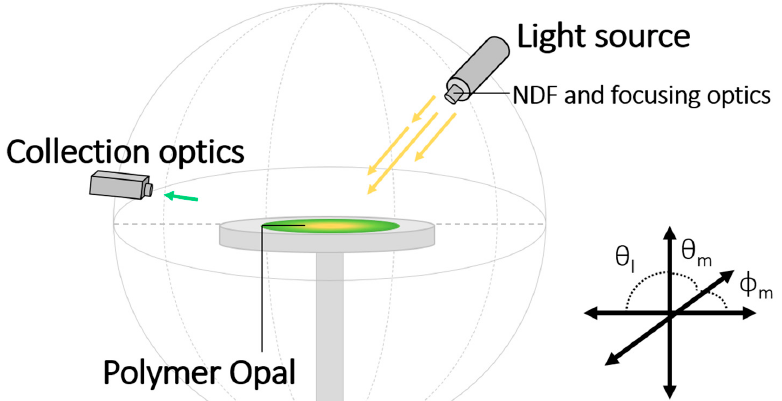
Figure 2. The three-dimensional reflectance goniometer instrumentation, with co-ordinate nomenclature inset. The polymer opal is situated in the center of the dark box environment, while the position of light source and collection optics with neutral density filter (NDF) are remotely controlled, allowing the relative reflectance to be measured under a range of viewing conditions. θ I defines the incident angle, ϕ m the viewing plane, and θ m the viewing angle within the plane.